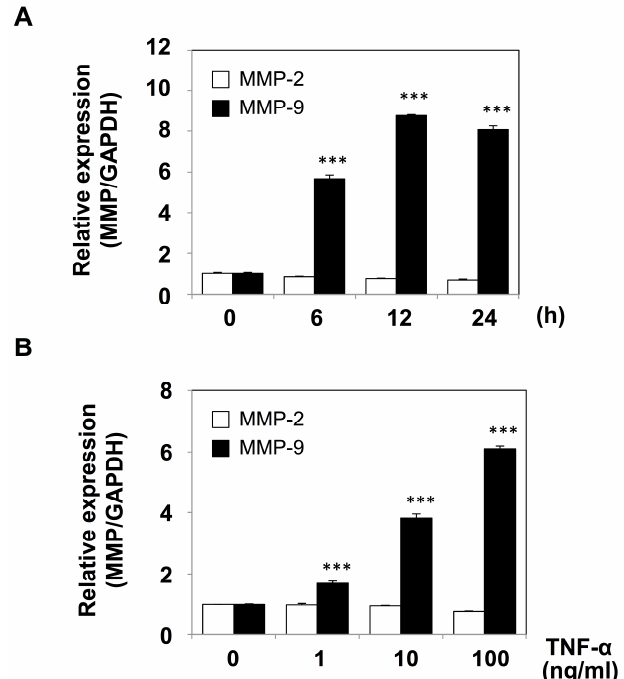
Figure 3. RT-qPCR analysis of mRNA for MMP-2 and MMP-9 in mesothelial cells after treatment with TNF- α . ( A ) Mesothelial cells were cultured in ASF104 serum-free medium containing TNF- α (10 ng/mL) at 37 ◦ C for 0, 6, 12 or 24 h. Total RNA was then isolated, and RT-qPCR for the genes for MMP-2 ( open bar ) and MMP-9 ( closed bar ) was carried out as described in Section 4. ( B ) Mesothelial cells were cultured in ASF104 medium containing TNF- α (0, 1, 10 or 100 ng/mL) for 6 h. The gene expressions of MMP-2 ( open bar ) and MMP-9 ( closed bar ) were analyzed by the relative standard curve method using Gapdh as an internal control. Experiments were performed in triplicate, and the data are presented as the mean ± SEM. Statistical data analysis was conducted using the Student’s t -test. *** p < 0.005 vs. control.